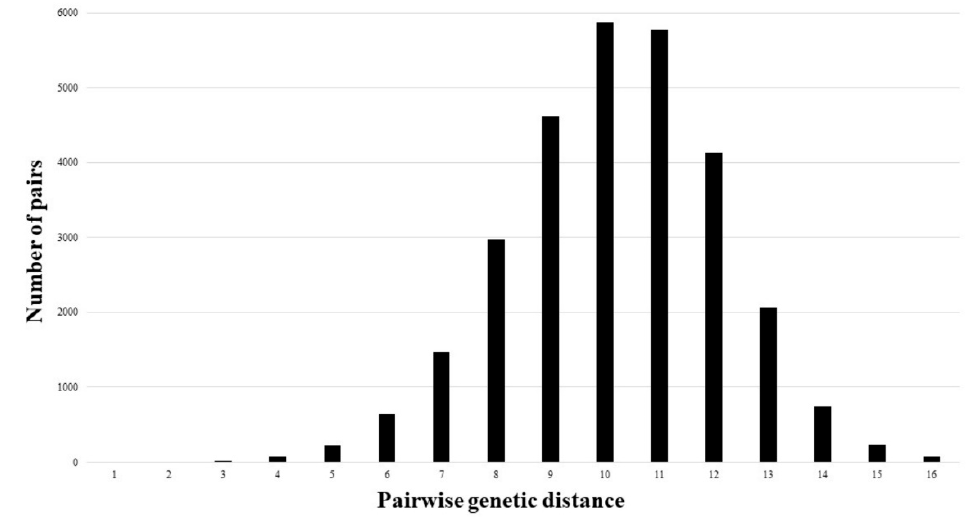
Figure 3. Distribution of pairwise genetic distance frequencies in accordance with given genetic distances.